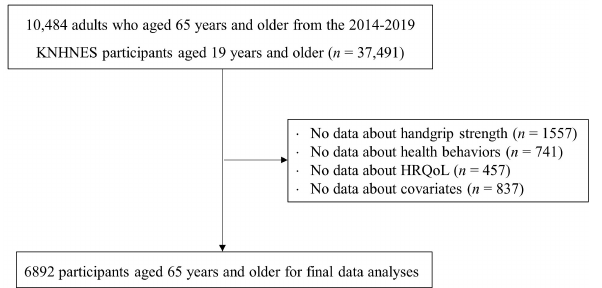
A flowchart for selection of study